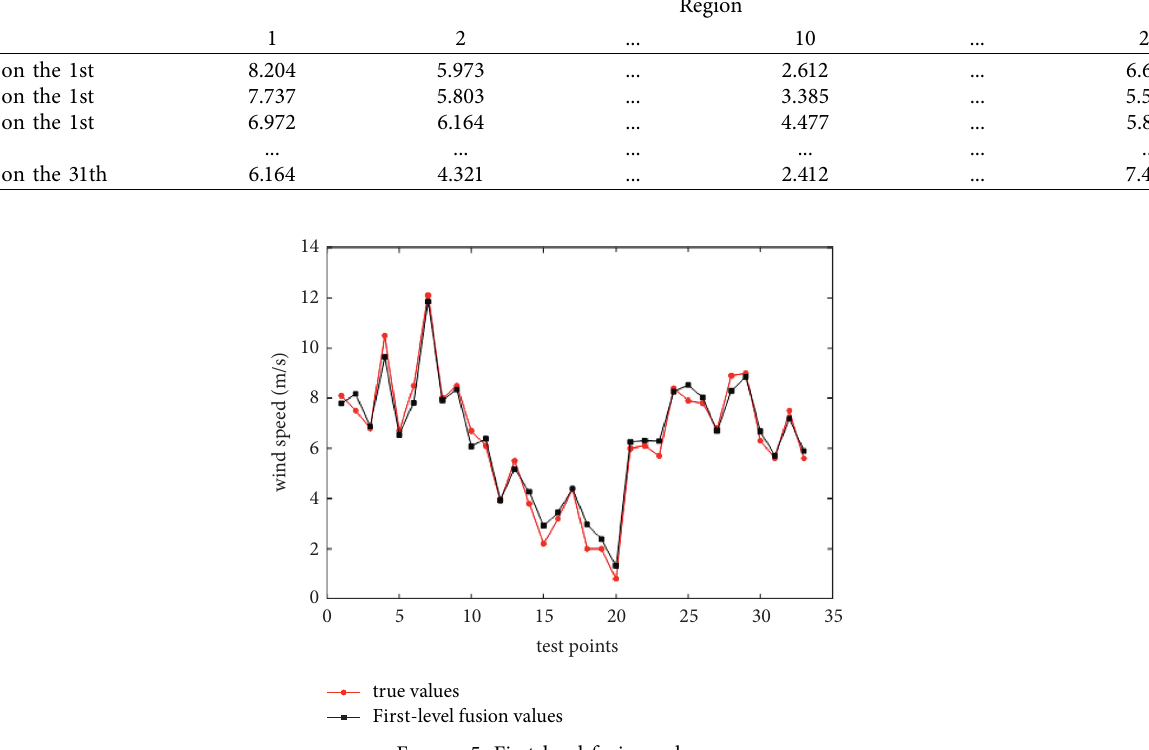
Figure 5: First-level fusion values.